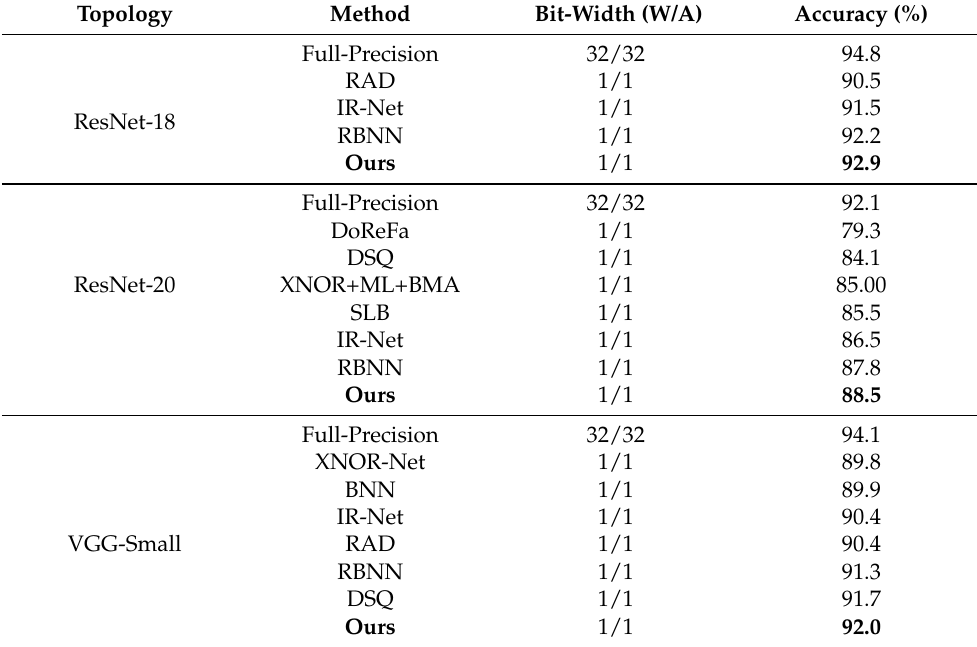
Table 4. Accuracy comparison with the SOTA methods on the CIFAR-10 dataset. We evaluate our proposed IE-Net based on ResNet-18, ResNet-20, and VGG-Small. The proposed networks are highlighted in